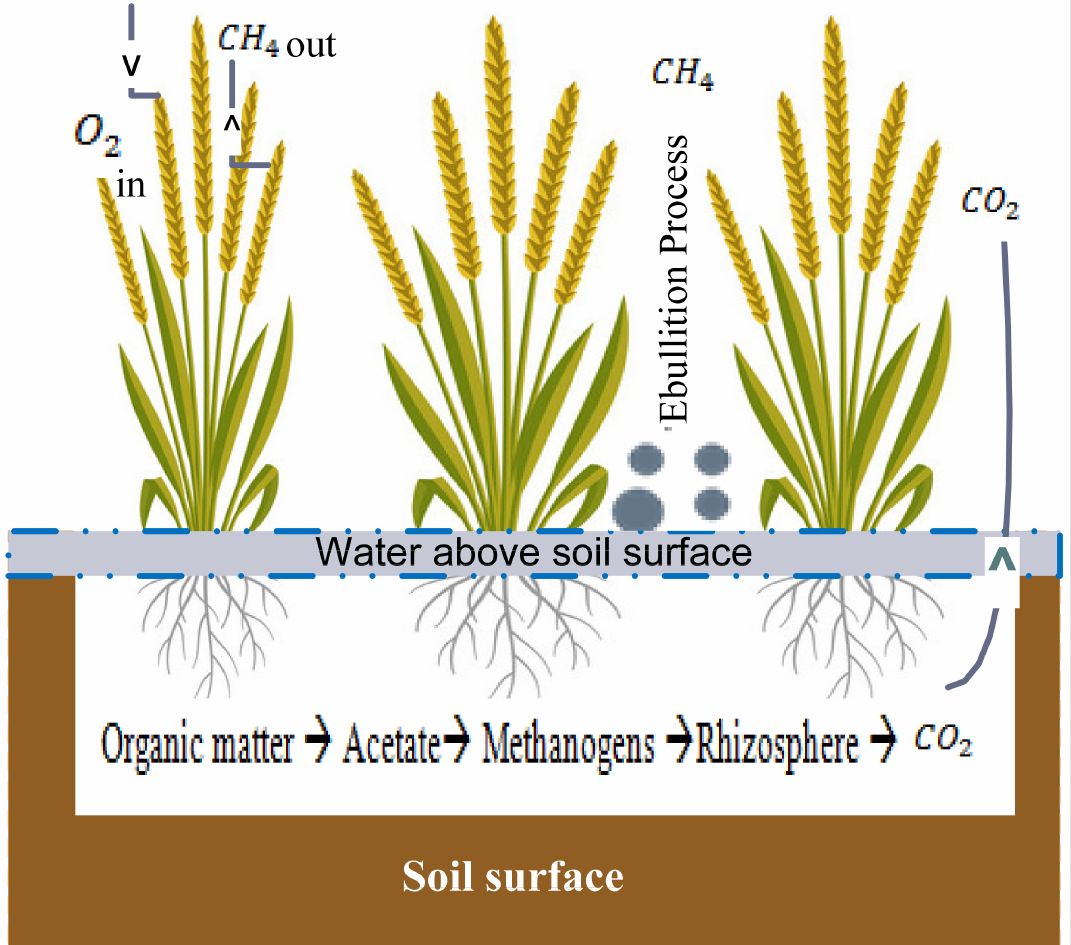
Figure 2. The process of CH 4 and CO 2 production and emission from rice